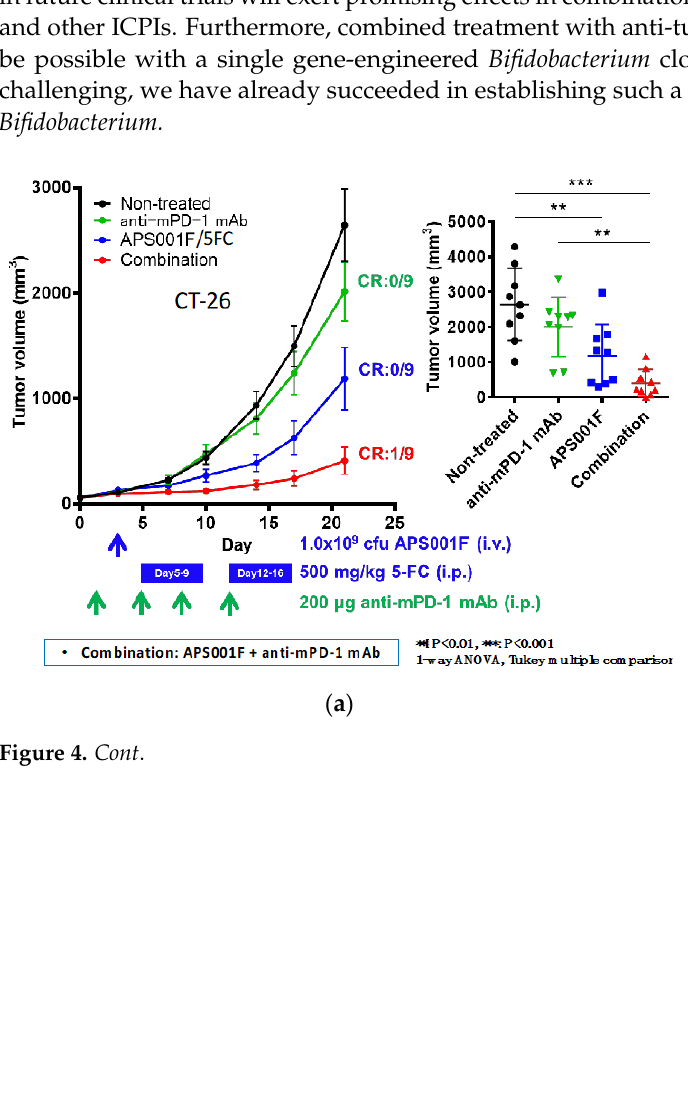
Figure 4. Anti-tumor effects of APS001F/5FC, anti-PD-1 mAb, and their combination were evaluated in a syngeneic CT26 mouse model. Experiment schedule. Mice were s.c. inoculated with 1 × 10 5 CT26 cells (day -13), and stratification was done on day 0. APS001F was administered i.v. at 1.0 × 10 9 c.f.u./mouse via the tail vein on day 3 with 200 mg maltose supplementation (days 3 through 16). 5-FC was administered i.p. at 250 mg/kg twice a day (500 mg/kg/day) on days 5 through 9 and days 12 through 16. Anti-PD-1 mAb was administered i.p. at 200 µg/mouse on days 1, 4, 8, and 11. Tumor volume was measured twice a week. ( a ) Change in tumor volume after treatment with APS001F/5-FC, anti-PD-1 mAb, and their combination. Results are the mean ± standard error of the mean of 9 mice. Analyses of 4 groups on day 21 were conducted using Tukey’s method of multiple comparisons. Means sharing a letter are not significantly different. Tumor Growth Inhibition was calculated on day 21. ( b ) Flow cytometric analysis of tumor cells in mice engrafted with CT26 cells. Results are the mean ± standard deviation of 8 mice. %CD45 + of total cells, %CD4 + of total cells, %Tregs (CD45 + CD4 + CD25 + Foxp3 + cells) of CD4 + cells, %CD8 + of total cells, CD8/Treg ratio, and %neutrophils (CD45 + CD11b + Ly-6G + cells) of total cells, and %TAMs (CD45 + CD11b + Ly-6G − Ly-6C low cells) of total cells were analyzed. Analyses of 4 groups were conducted using Tukey’s method of multiple comparisons. Means sharing a letter are not significantly different. This figure was adopted from a previous study [48].